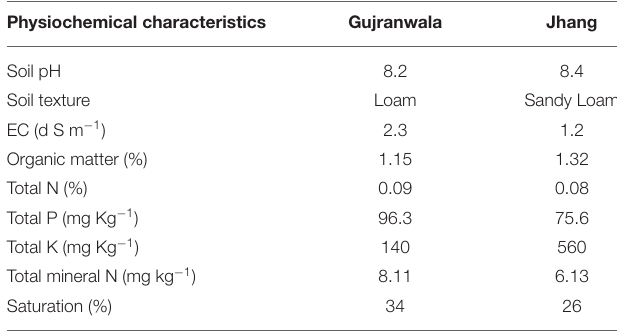
TABLE 1 | Physiochemical characteristics of Gujranwala and Jhang soil samples collected from potato rhizosphere. Physiochemical characteristics